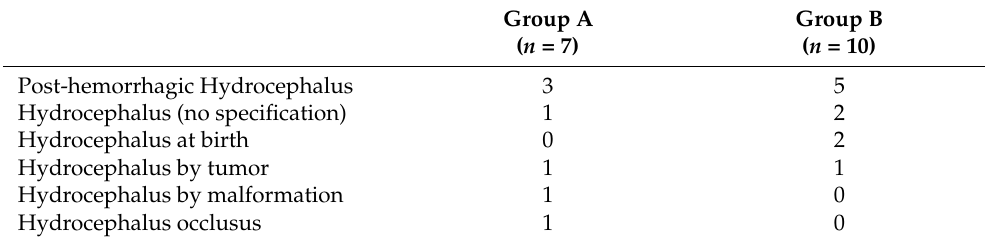
Table 2. Reason for initial shunt placement in the study’s patients.